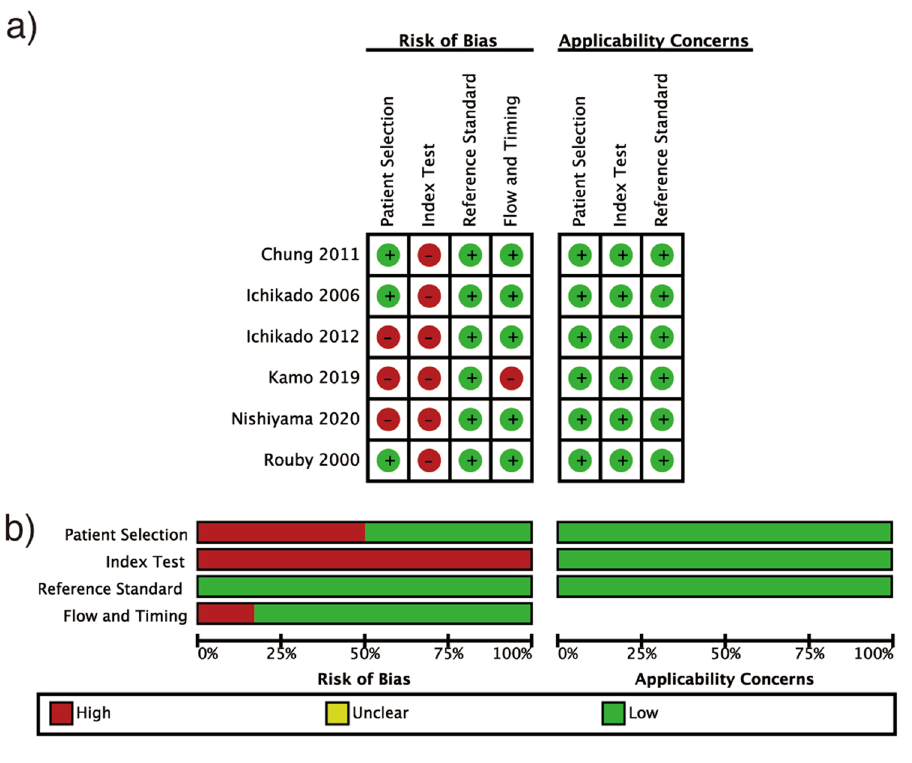
Figure 2. Risk of bias and applicability concerns ( a ) summary and ( b ) graph.